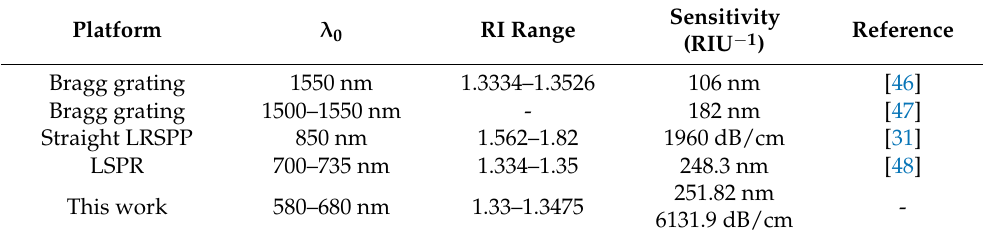
Table 5. Comparison of the performance metrics of selected optical biosensors.